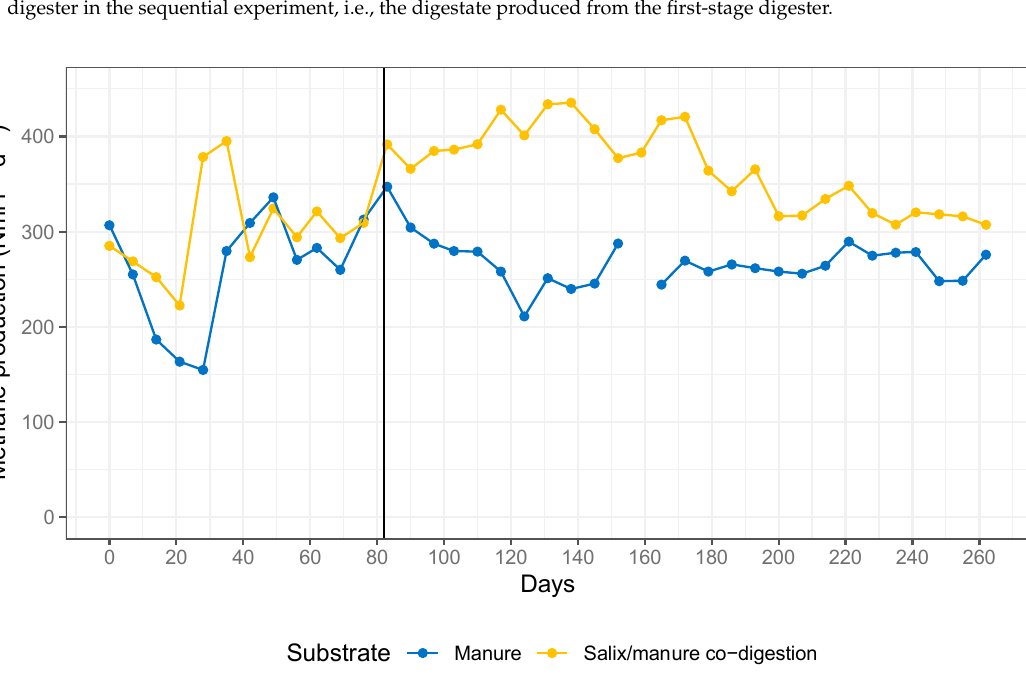
Figure 4. Volumetric methane production (weekly averages) for the single stage continuous digestion processes. The vertical line indicates where the target organic loading rate (OLR) was reached. Data are missing for the manure reactor at day 159 due to a gas leak. Table 3. Process performance parameters for the single-stage and sequential co-digestion experiments and the manure control. VS: volatile solids.